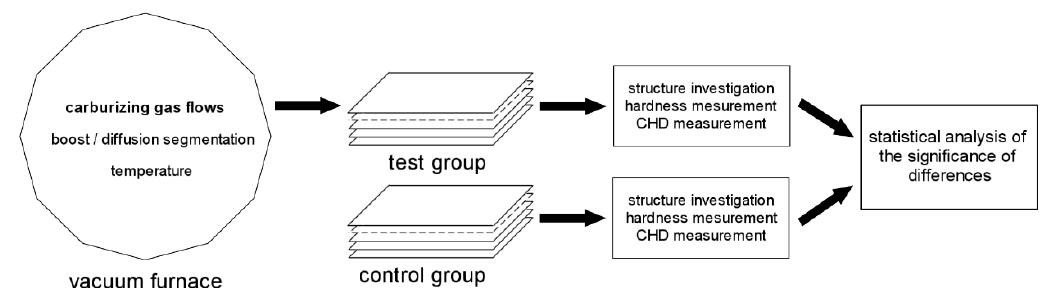
Figure 2. Block scheme of the experimental system: test group (32 parts) randomly taken from 3240-part batch (resulting from variable-flow LPC process), investigated and compared with the control group (resulting from constant-flow LPC process).